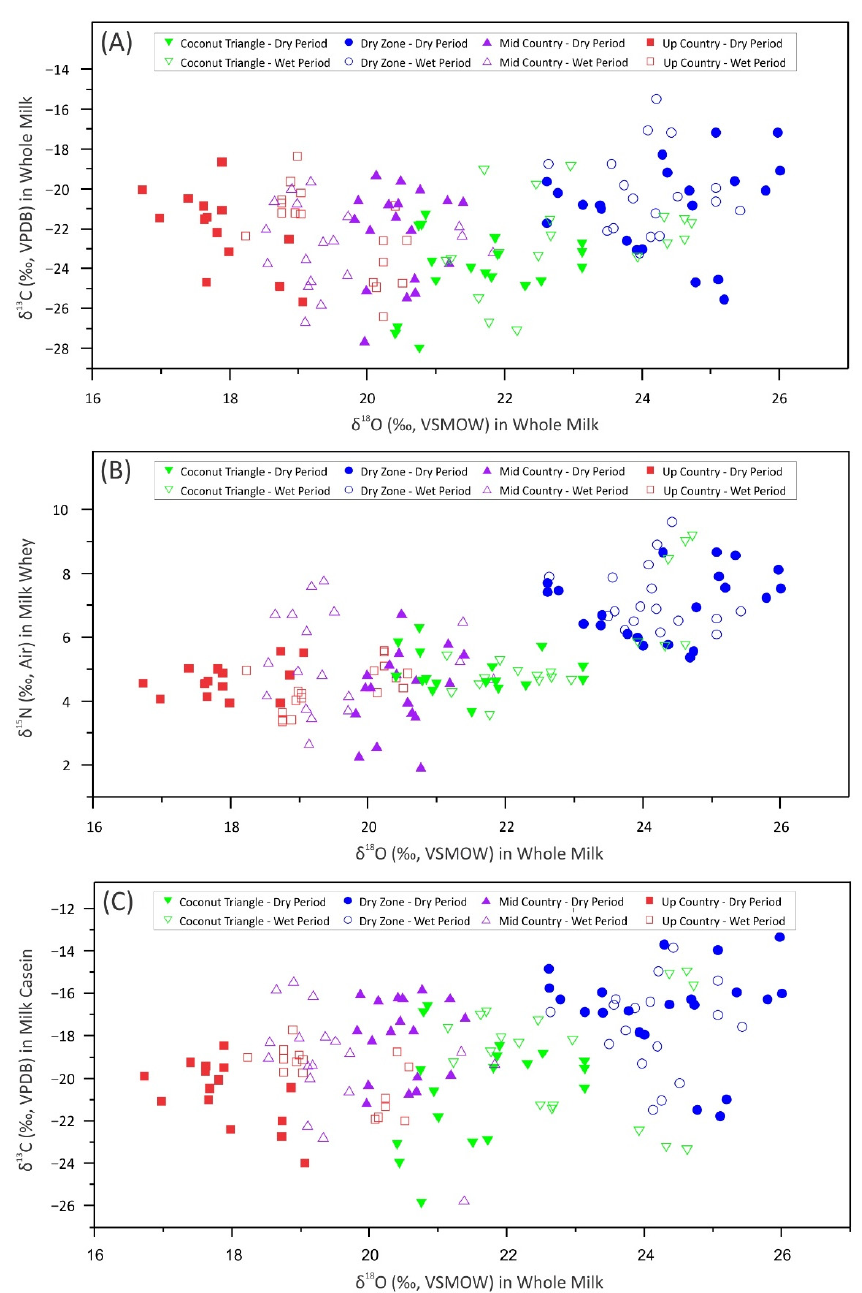
Figure 4. Scatter diagrams of distribution of stable isotopes values. ( A ) δ 18 O ‰ in whole milk vs. δ 13 C ‰ in whole milk, ( B ) δ 18 O ‰ in whole milk vs. δ 15 N ‰ in milk whey, ( C ) δ 18 O ‰ in whole milk vs. δ 13 C ‰ in milk casein.